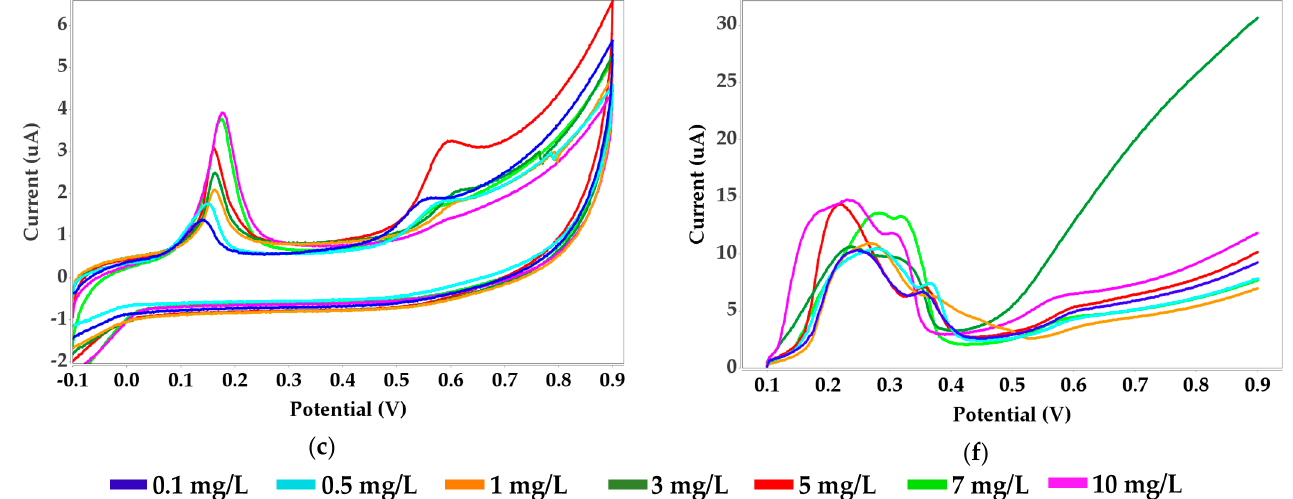
Figure 2. Voltammograms obtained for nickel standard solution and urease immobilized with alginate; CV with SPEs: ( a ) carbon, ( b ) bismuth, ( c ) silver; LSV with SPEs: ( d ) carbon, ( e ) bismuth, ( f ) silver.